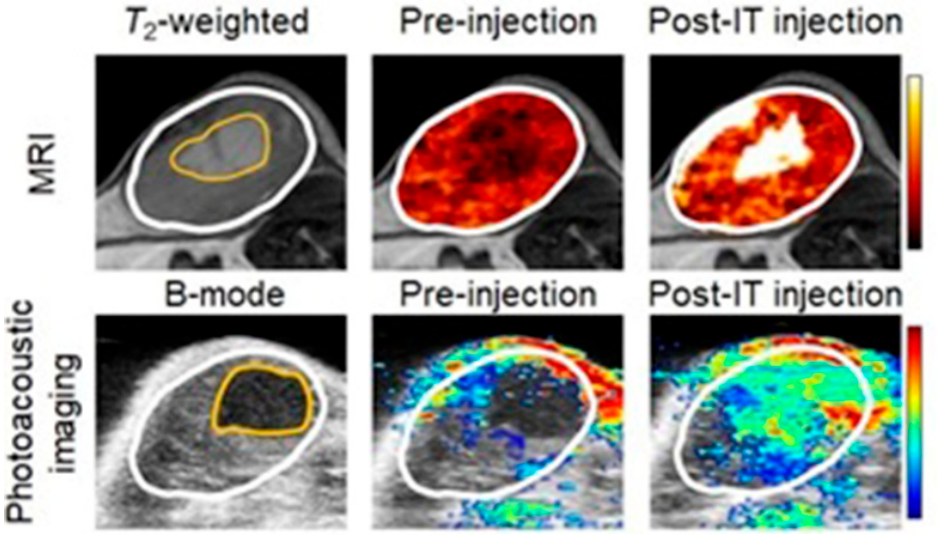
Figure 57. Ultrasound-guided intratumoral (IT) injection of MnO 2 -containing nanoparticles into head and neck squamous cell carcinoma-bearing mice. Panels of T 2 -weighted MRI and photoacoustic images showing before and after direct delivery of nanoparticles to hypoxic region (outlined in yellow) within the tumor (outlined in white). Adapted with permission [373].